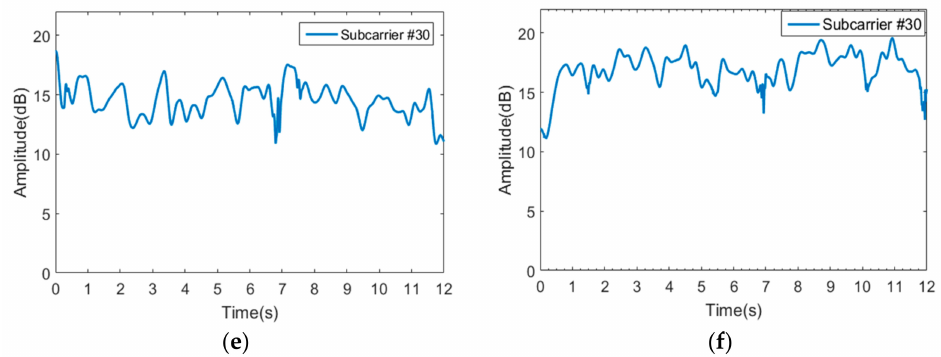
Figure 7. The waveforms of each action after data preprocessing: ( a ) normal standing; ( b ) standing of Huntington’s disease (HD); ( c ) normal sitting; ( d ) sitting of HD; ( e ) normal walking; ( f ) gait of